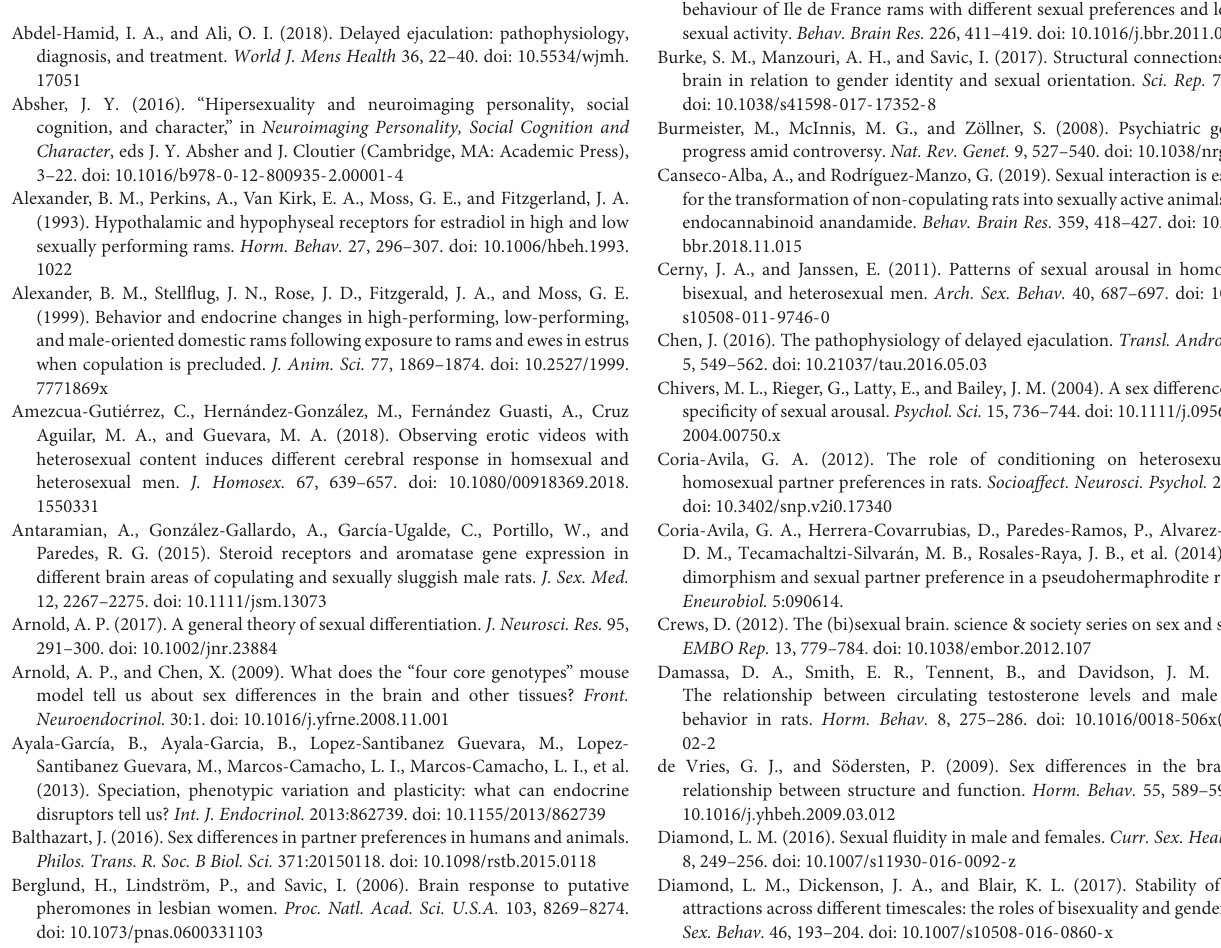
EN-phenotyped males. Amygdala: AMG; Olfactory bulb: OB; Medial preoptic area: MPOA; Ventromedial hypothalamus: VMH. FIGURE S5 | Principal component analyses criteria of design. In our study, we assessed the internal consistency of the presumed ejaculatory endophenotypes by evaluating the distribution of copulating male rats after introducing the way all copulatory parameters interact one another per phenotyped animal, through a principal component analysis (PCA). After evaluating the percentage of variance retained by each principal component (A) , we decided to run a two-dimensional analysis because components 1 and 2 explained up to 82.1% of the sample’s variance. This decision was proved to be correct since the values of the square cosine (Cos 2 ) for each of the copulatory variables considered in the analysis were all above 0.5 (B) , so they all are adequately represented in the sample examined through the two dimensional analysis, Finally, the percentage of contribution of every variable per component was estimated (C,D) . The red dashed line in C and D indicates the expected average contribution (16.7%). Having this reference in mind, it becomes clear that mount (ML) and intromission (IL) latencies together with mount (MN) and intromission (MN) cumulative numbers explain most of the sample variance associated to component number one (C) and that ejaculation number (EN) and latency (EL) together with mount (MN) and intromission (IN) numbers mainly explain the variance associated to component number two (D) . EL, ejaculation latency; EN, cumulative ejaculation number; IL, intromission latency, IN, cumulative intromission number; ML, mount latency; MN, cumulative mount